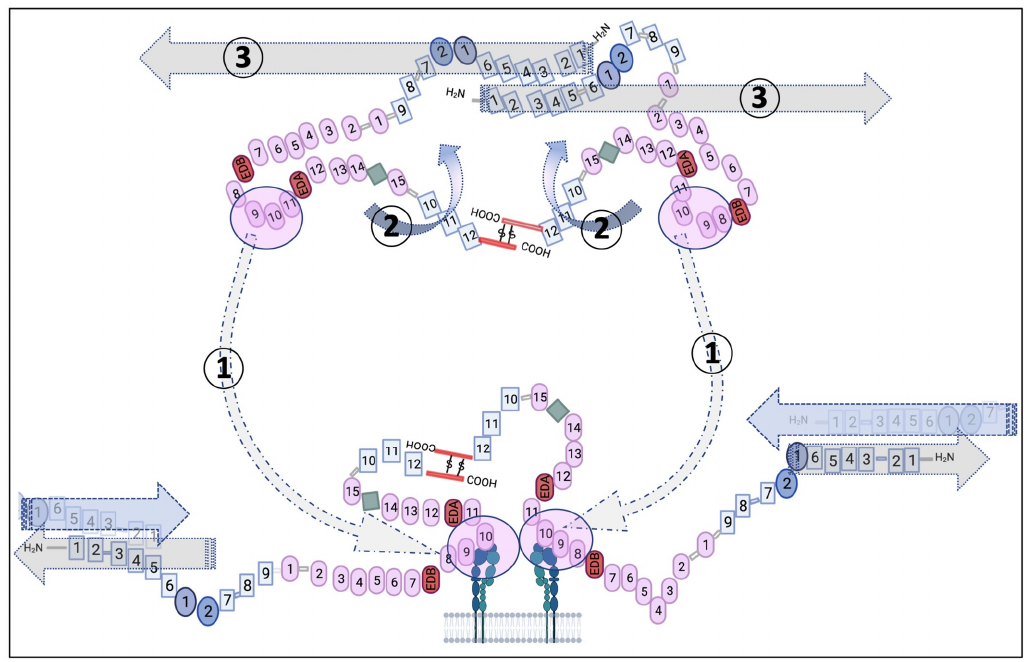
Figure 3. Schematic representation of the major steps that mediate an Fn fibrillar assembly at the interfaces and lead to a structural Fn reorganization from a soluble compact form to aligned Fn molecules with fibrils. First, the III-9 and III-10 modules of each chain of the soluble Fn bind to the integrins clustered at the surface ( 1 ). This triggers a reorganization of both the type III modules around the cell-binding domain and that of the disulfide bridge cross-links at the C-terminal part of each chain in a double-folded loop orientated to face the integrins and a dissociation of the N-terminal dimer assembly with a motion of the row of the six type I modules at the N-terminal site that now become aligned in parallel to the membrane, opposite to the orientation in a solution ( 2 ). This opening and new orientation of the N-terminal Fn-assembly domain favors interactions with the N-terminal domain of another Fn molecule and, consequently, initiates Fn fibrillogenesis ( 3 ).